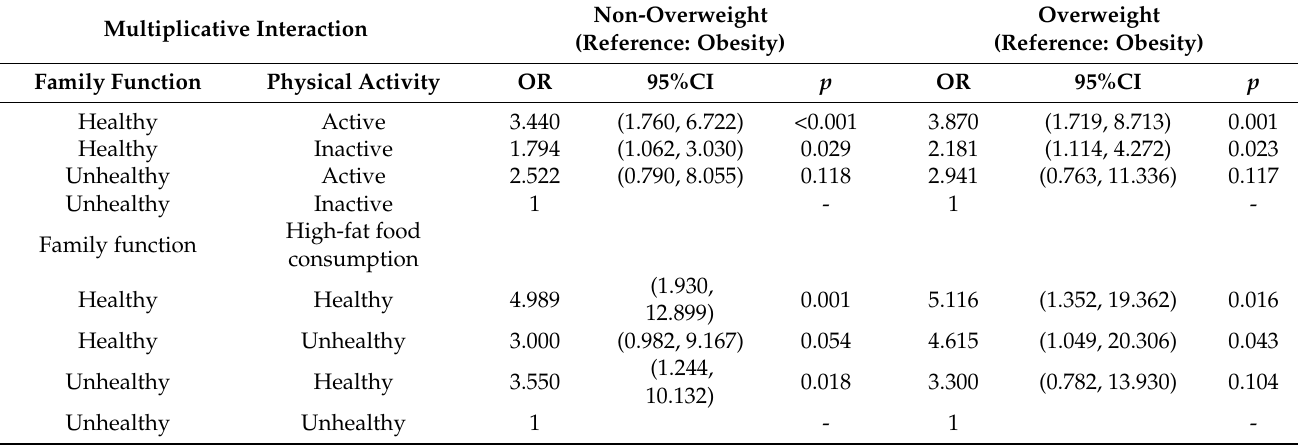
Table 4. The logistic regression of multiplicative interaction.